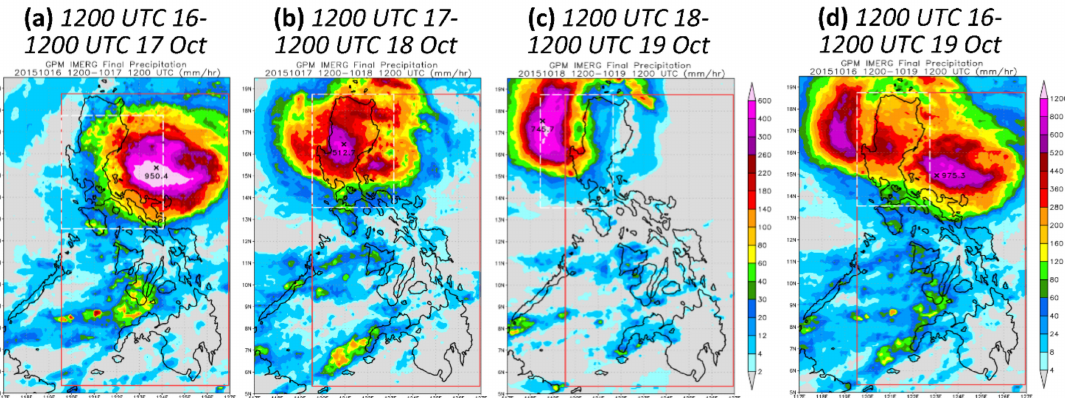
Figure 9. As in Figure 4, except for the GPM IMERG rainfall observation (mm, color), for the 24 h period of ( a ) 1200 UTC on 16 to 1200 UTC on 17, ( b ) 1200 UTC on 17 to 1200 UTC on 18, ( c ) 1200 UTC on 18 to 1200 UTC on 19, and ( d ) for the 72 h period of 1200 UTC on 16 to 1200 UTC on 19 Oct during TY Koppu (2015). Panels ( a – c ) used the same color bar plotted on the right side of ( c ).